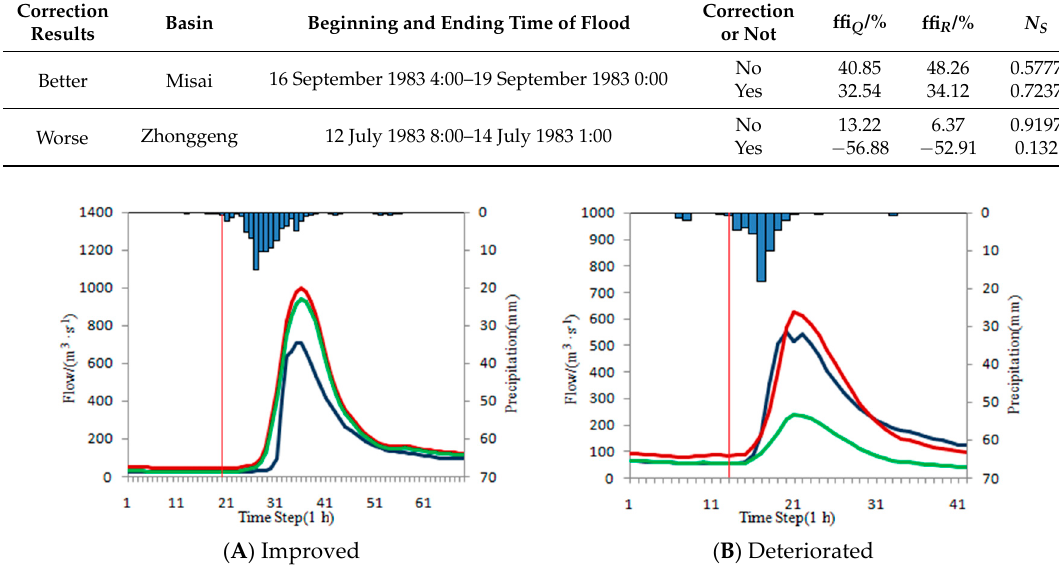
Figure 11. Accuracy improved and deteriorated floods of over-estimated floods.